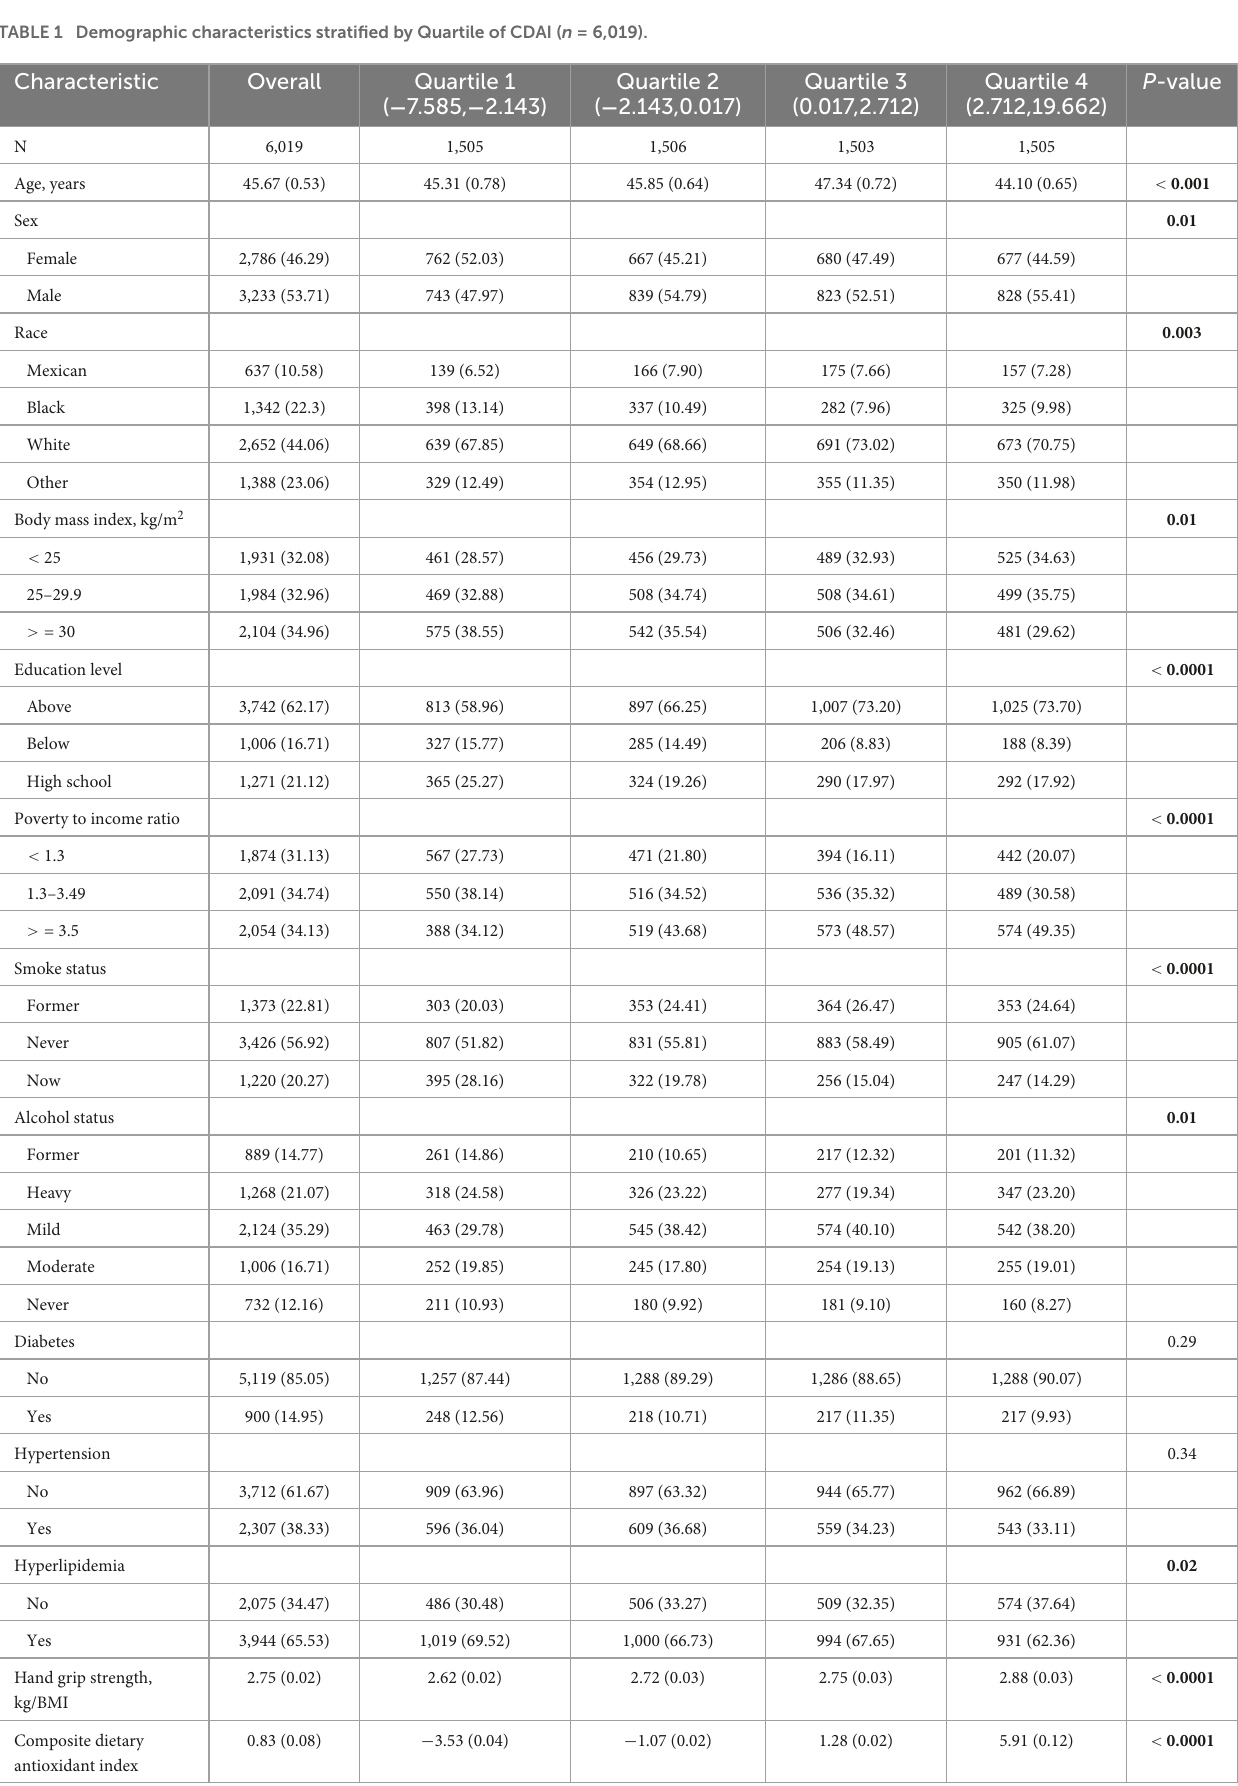
TABLE 1 Demographic characteristics stratified by Quartile of CDAI ( n = 6,019).